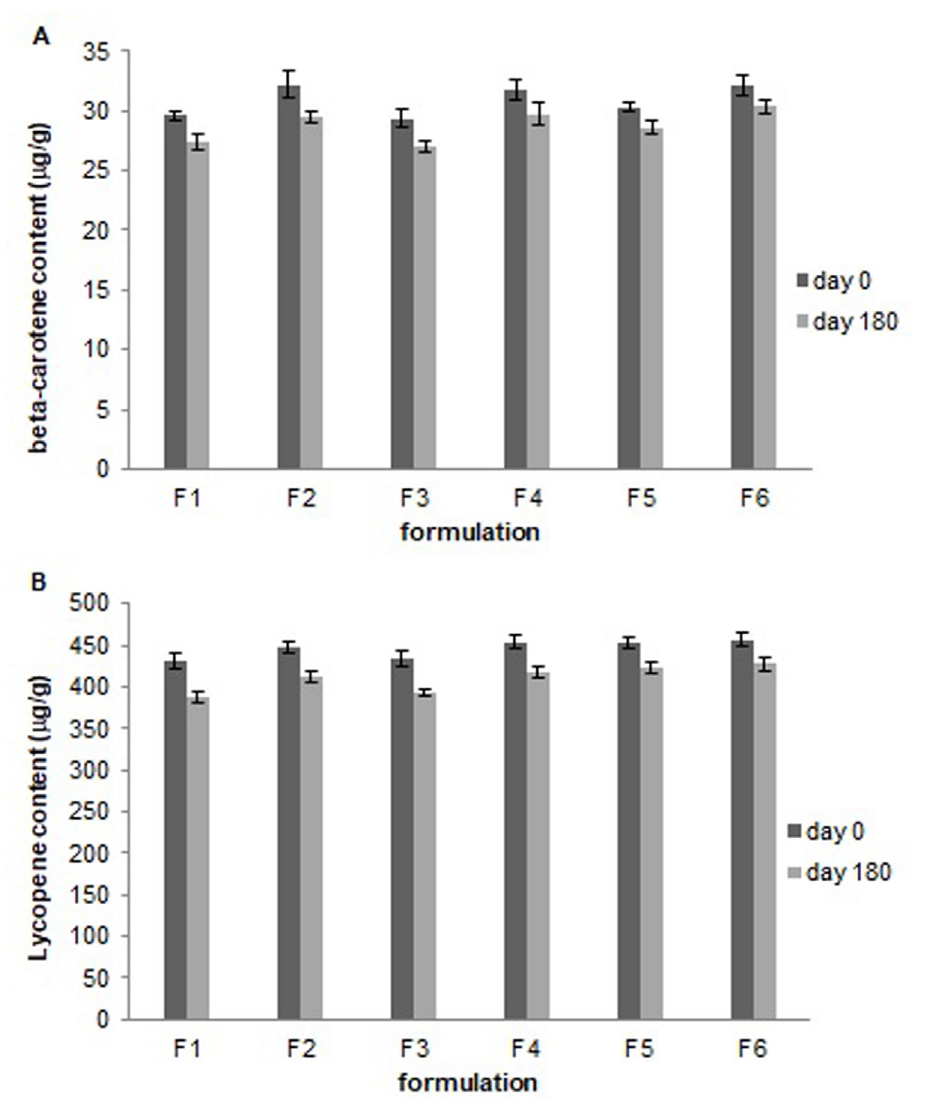
FIGURE 2 - The amount of carotenoids in the prepared hydrogel formulations on days 0 and 180 (after storage at 40 °C/75% RH) (A): beta-carotene and (B): lycopene (mean ± SD, n =